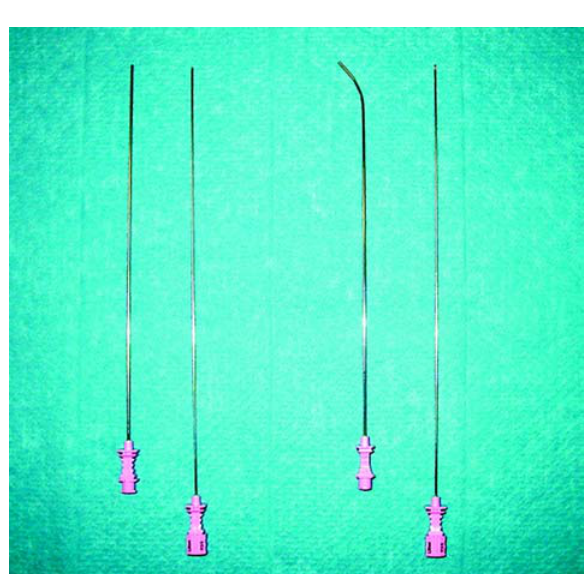
Figure 2 – Original (left) and bent (right) puncture needle both with